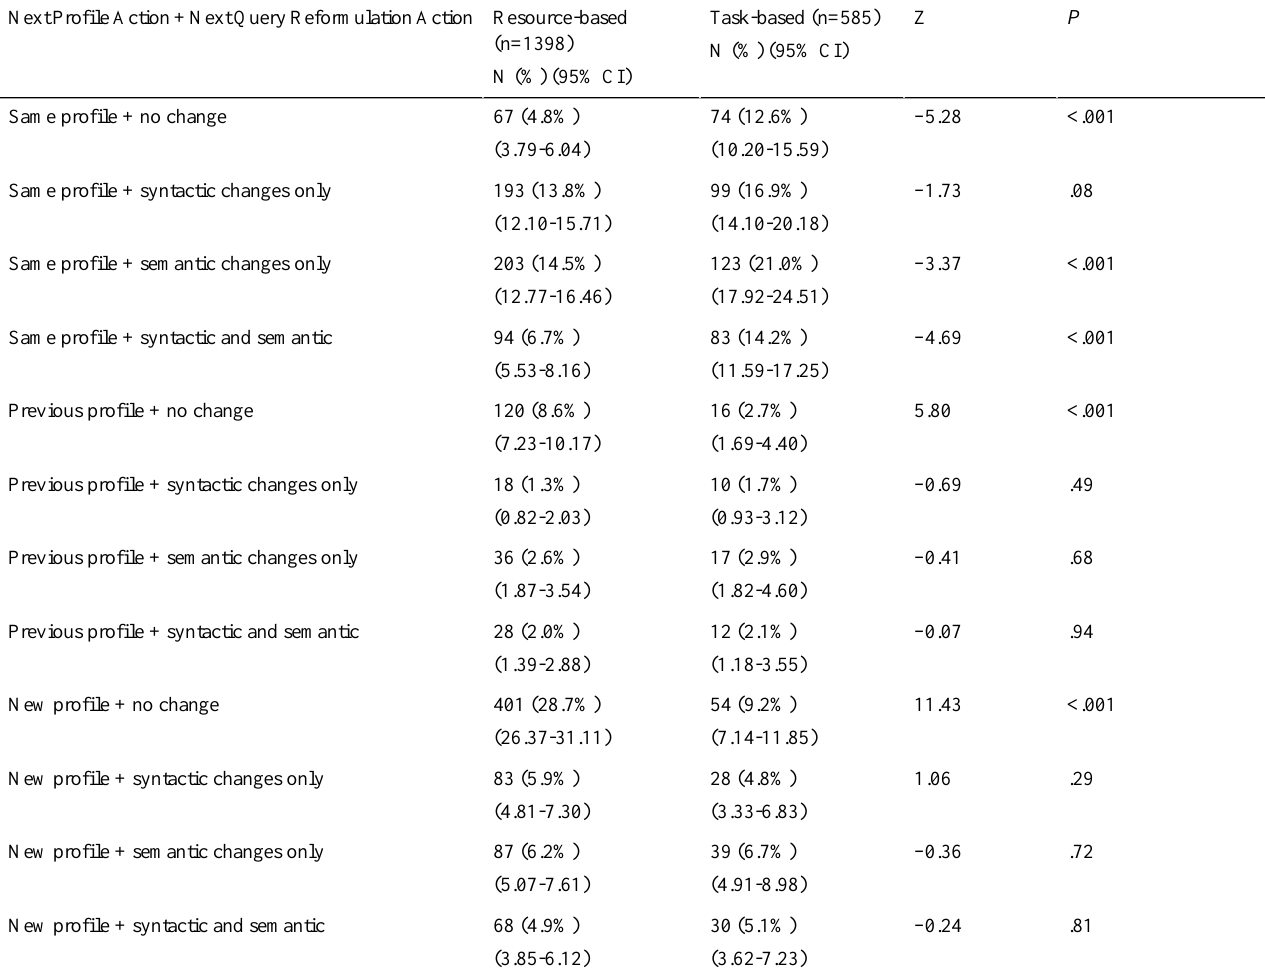
Table 5. Comparison of profile and query reformulation actions between resource-based and task-based systems